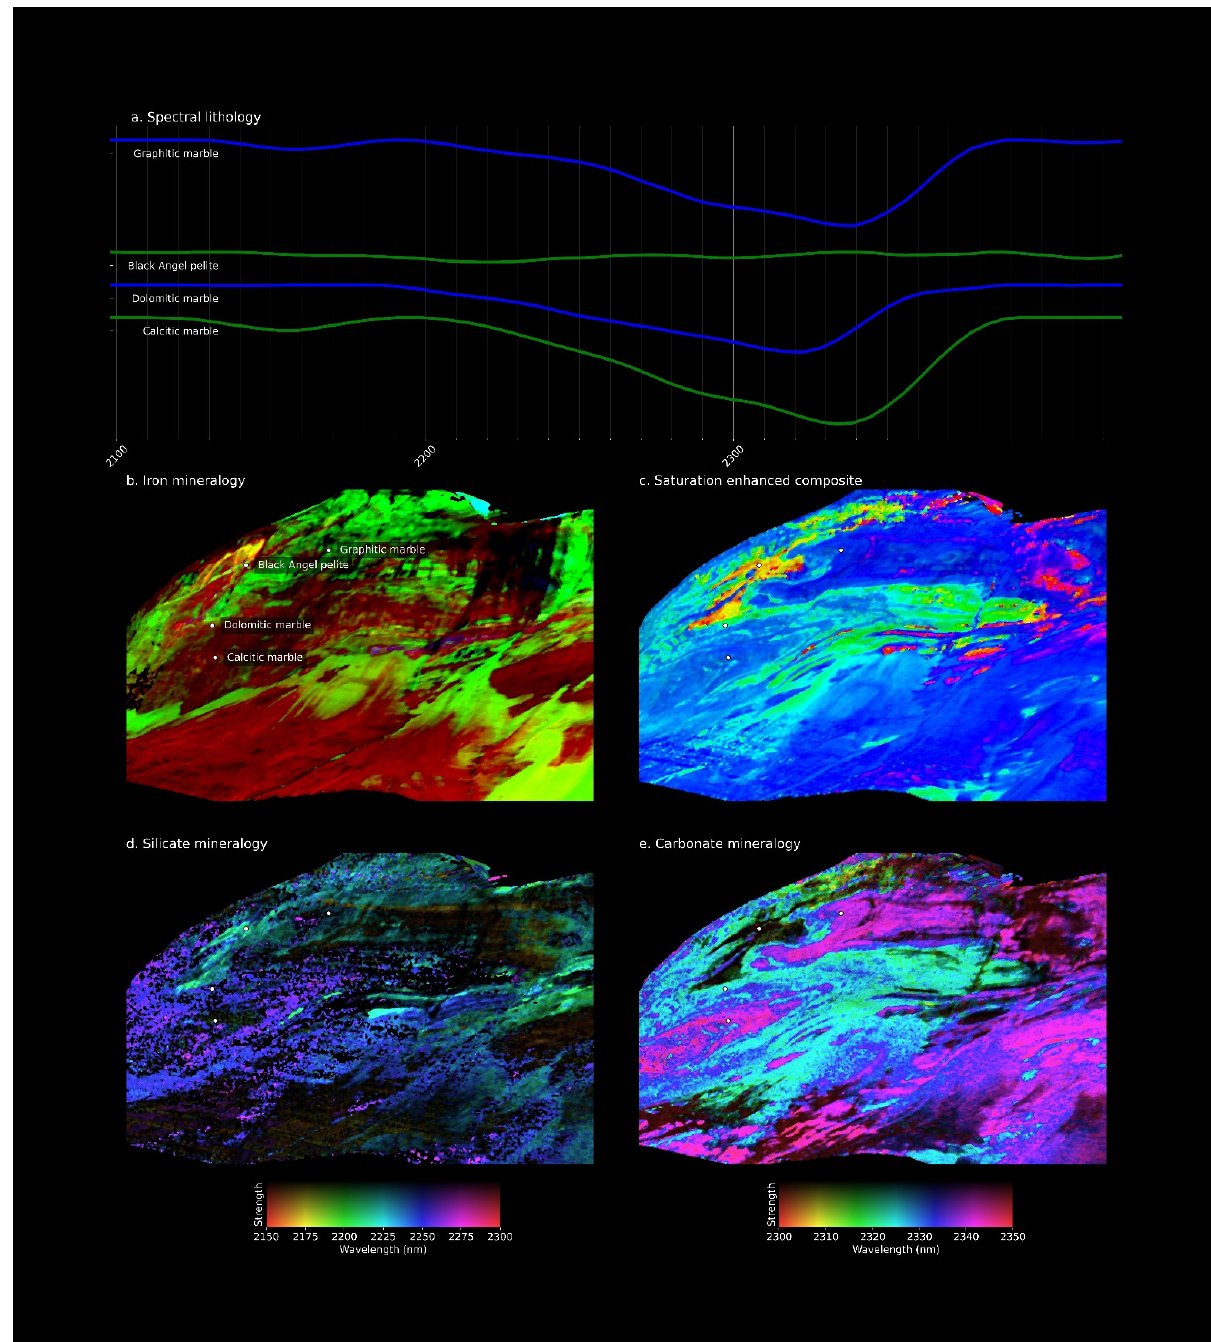
Figure 6. View of the main Maarmorilik cliff looking NE-wards and showing the main hyperspectral visualization products used to identify and map stratigraphic horizons. The shortwave infrared contains several diagnostic absorption features allowing the characterization and discrimination of many of the lithologies in the Marmorilik formation ( a ). These allow qualitative mapping of iron mineralogy ( b ) using standard band-ratio approaches [33] and the identification of otherwise cryptic stratigraphic horizons using false-color visualizations of spectral absorbance at 2200, 2250 and 2350 nm ( c ). More detailed insights can be gained using minimum wavelength mapping techniques to identify silicate ( d ) minerals containing Al-OH (e.g., white mica and clay minerals; green to cyan) and Fe-OH (e.g., amphibole, chlorite; blue to purple), or distinguish ( e ) calcitic (purple) and dolomitic (cyan) marbles.